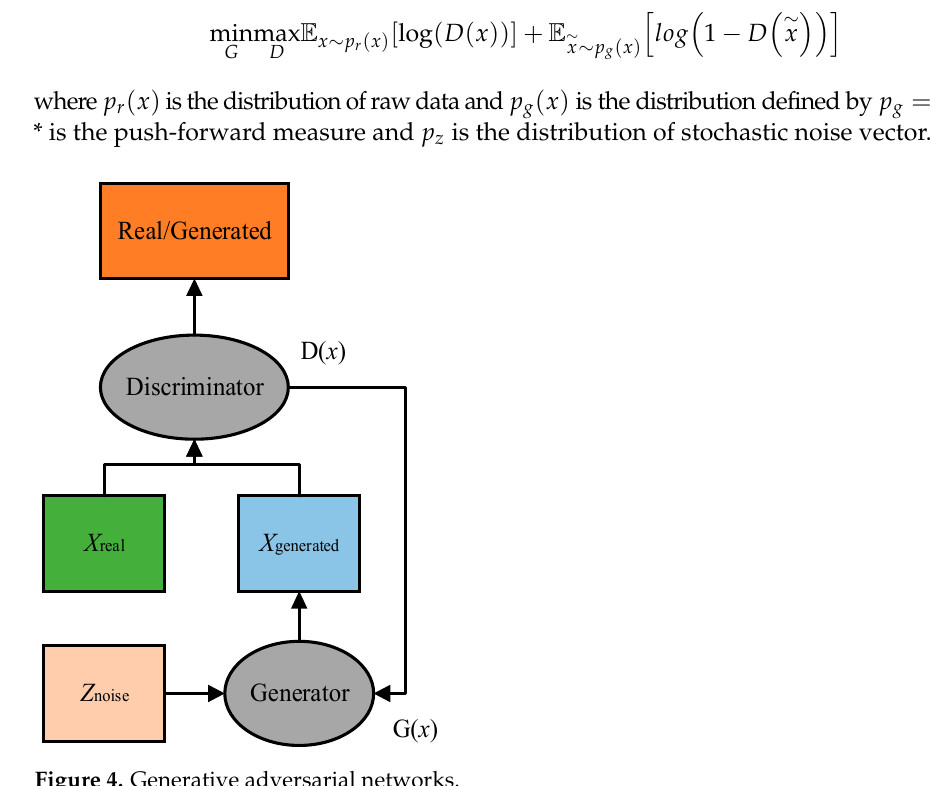
Figure 4. Generative adversarial networks.